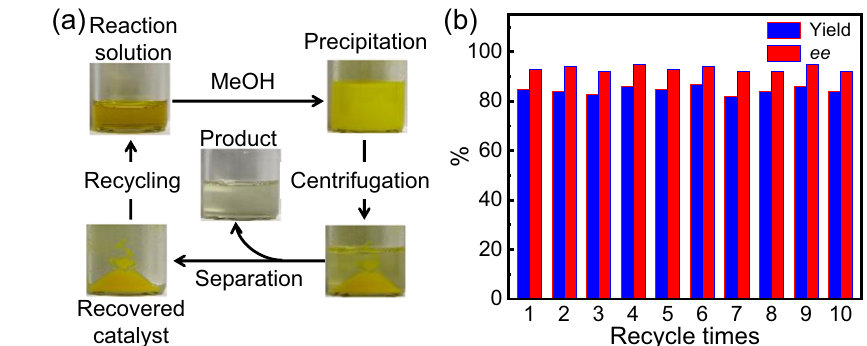
Fig. 3 | Recycle diagram and result statistics of catalysts. a Process of the catalyst recovery and recycling. b Yields and ee values of the products obtained from the asymmetric reaction of 3 catalyzed by recycled M -poly(L- 1 150 - b - 2 10